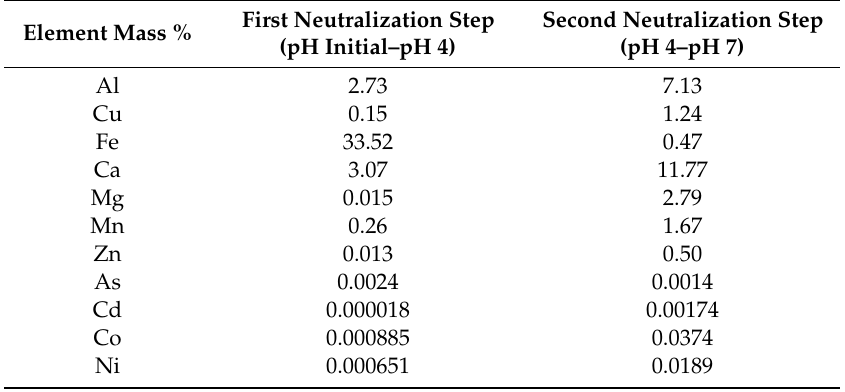
Table 6. Chemical composition of the sludge obtained in the two-step neutralization process. Element Mass